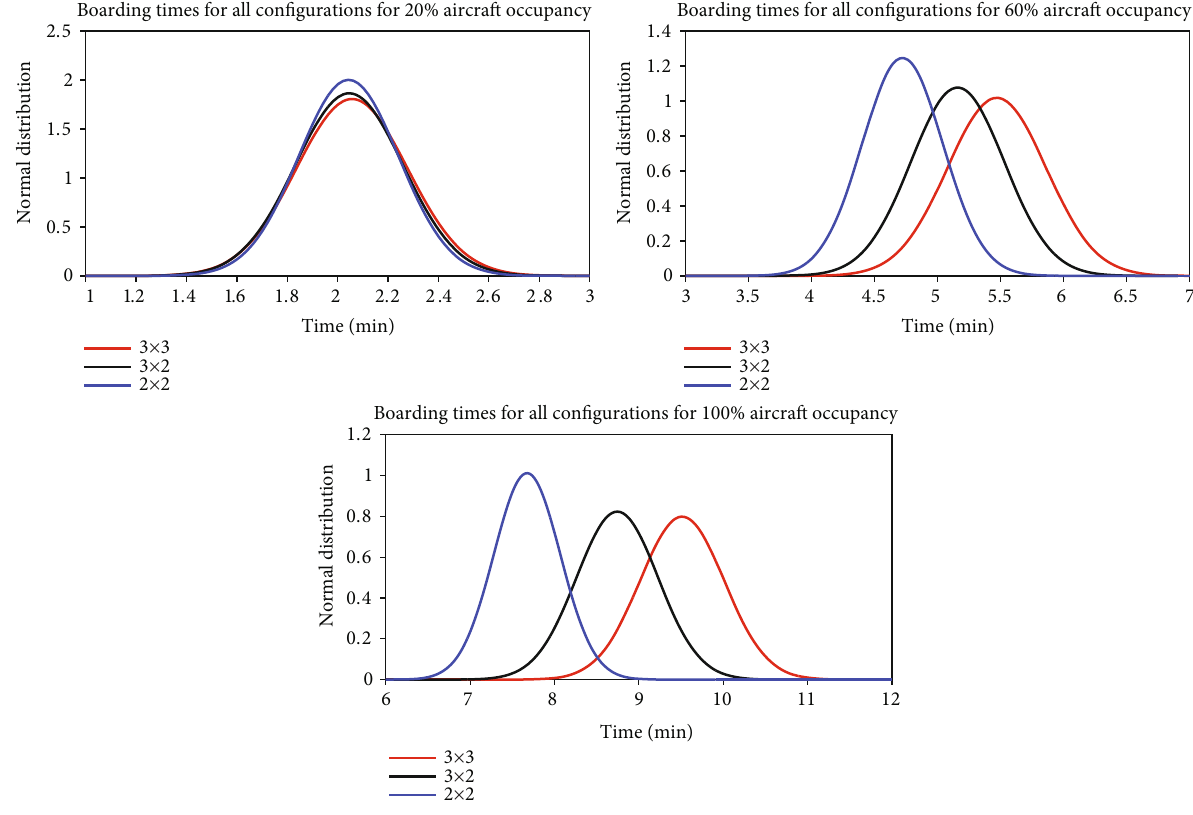
Figure 6: Fitted normal distribution curves for each aircraft con fi guration using the random boarding strategy for di ff erent % of aircraft occupancy. Table 6: Complete comparison of boarding times for the three aircraft con fi gurations using the random boarding strategy for di ff erent % of aircraft